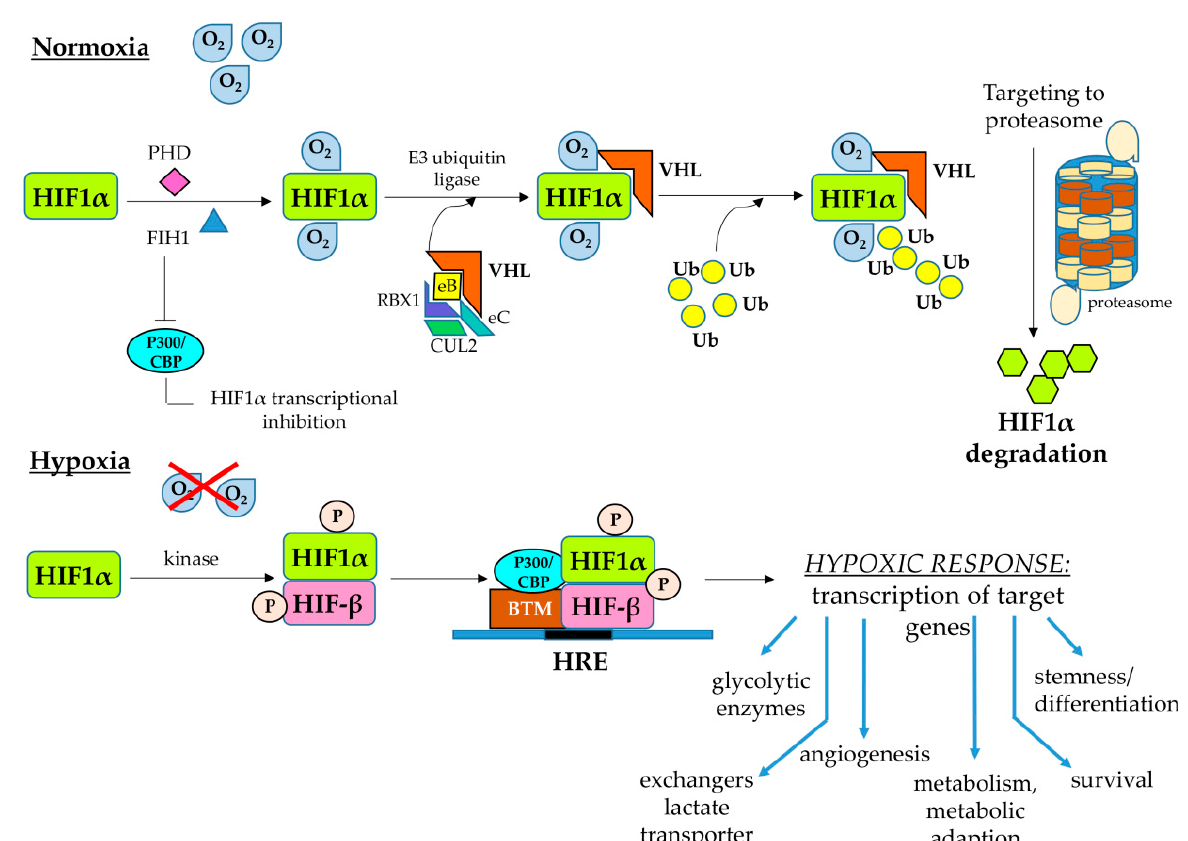
Figure 1. HIFs regulation under normoxic or hypoxic conditions and the hypoxic response. In normoxic conditions, the transcriptional action of heterodimeric hypoxia-inducible factors (HIFs) is prevented by changes introduced into the HIF- α subunit (here HIF-1 α is shown) by the action of either prolyl hydroxylases (PHD) or factor inhibiting HIF1 (FIH1). In particular, following the action of PHD, the modified HIF-1 α can be recognized by the von Hippel–Lindau (VHL) E3 ubiquitin ligase complex, poly-ubiquitinated (Ub-ubiquitin) and then degraded by the proteasome. Under hypoxic conditions, PHD and FIH are progressively inhibited in an O 2 -dependent manner and the heterodimer HIF-1 α /HIF-1 β can be phosphorylated and stabilized to then form a transcriptional complex with cAMP-response element binding (CREB)-binding protein (CBP) and histone acetyltransferase p300 (p300/CBP) and bind to hypoxia-responsive elements (HRE) in the promoter or enhancer regions of target genes. More details can be found in the text.